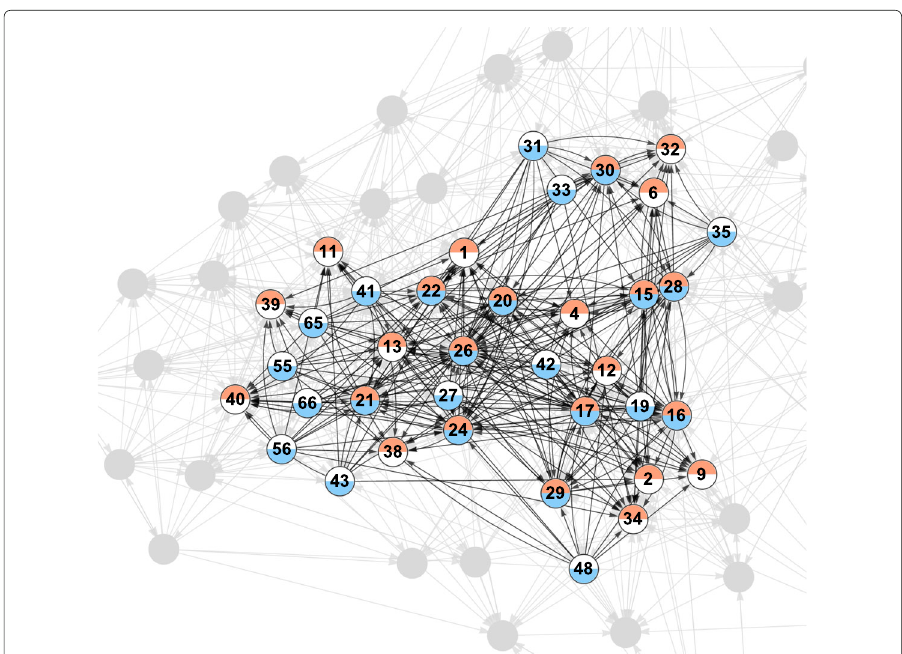
Fig. 6 The 9-9 BHA-core of the lawyers advice subnetwork associated to the bi-pattern ({25 < Age ≤ 50, Seniority ≤ 25}, {30 < Age ≤ 65, 5 < Seniority}). Vertices from 1 to 36 are partners, the other are associates. Vertices both red and blue have both the hub and authority